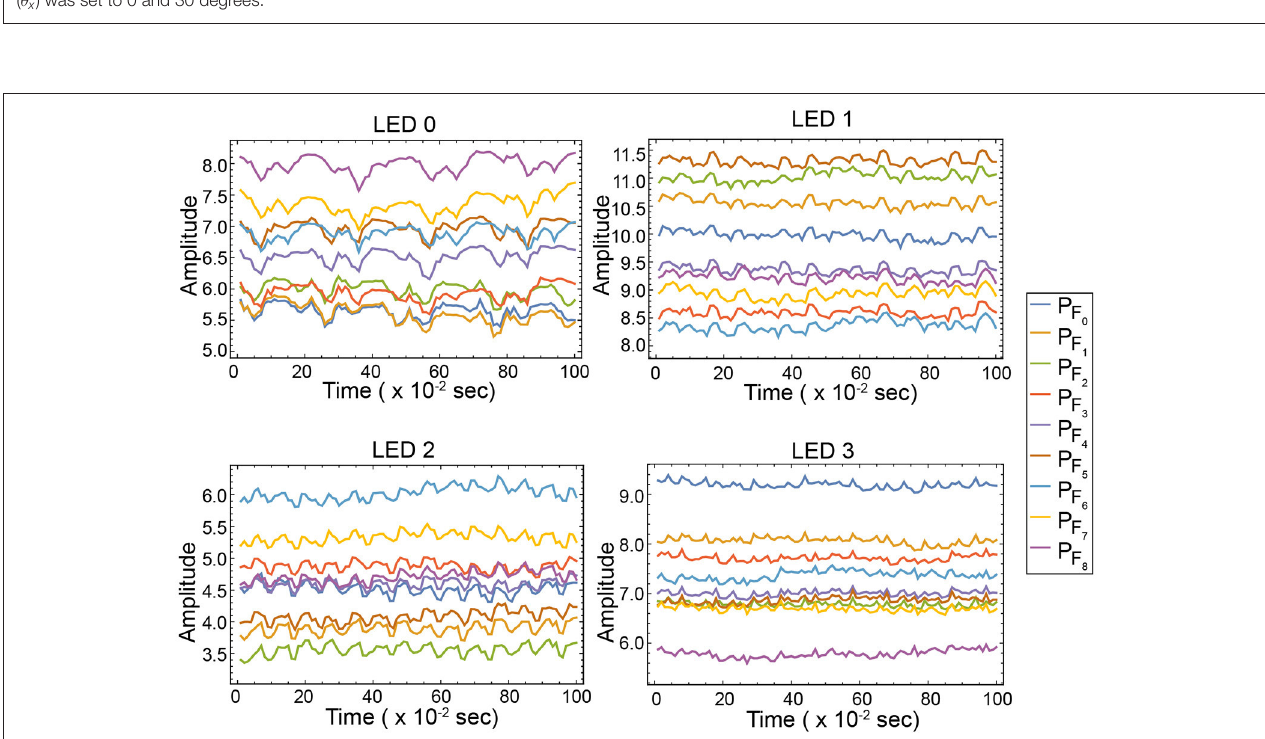
FIGURE 13 | Examples of captured signals at P F the frequency domain representation. The smartphone was placed at ( x , y , z ) = (2.5,2.5,1.15) and its yaw angle ( θ z in Figure 1 ) was set to 0 degrees. The pitch angle ( θ x ) was set to 0 and 30 degrees.